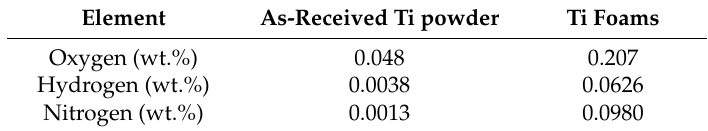
Table 1. Average O, H, and N contents of starting Ti powders and manufactured Ti foams.